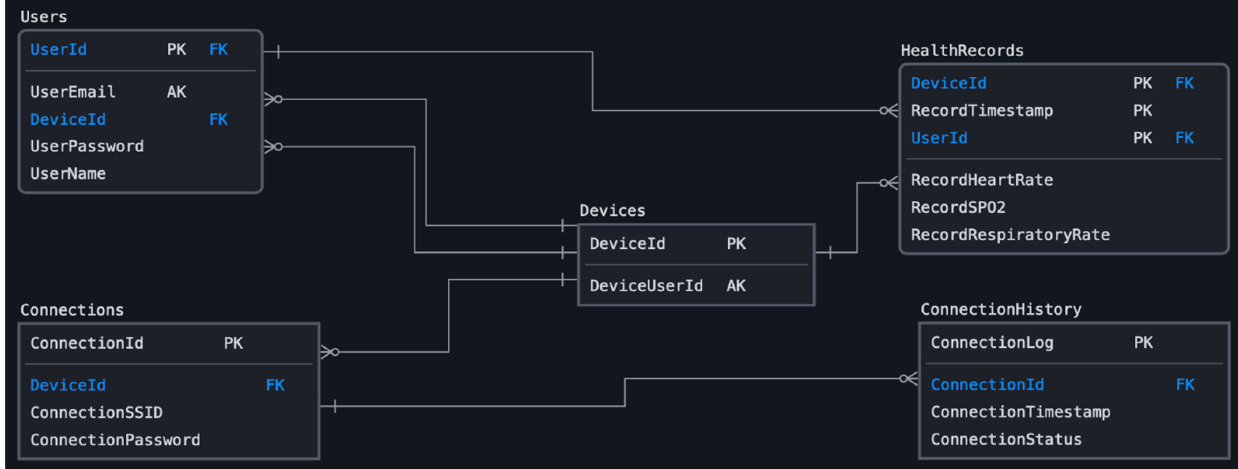
Figure 14. Database schema.